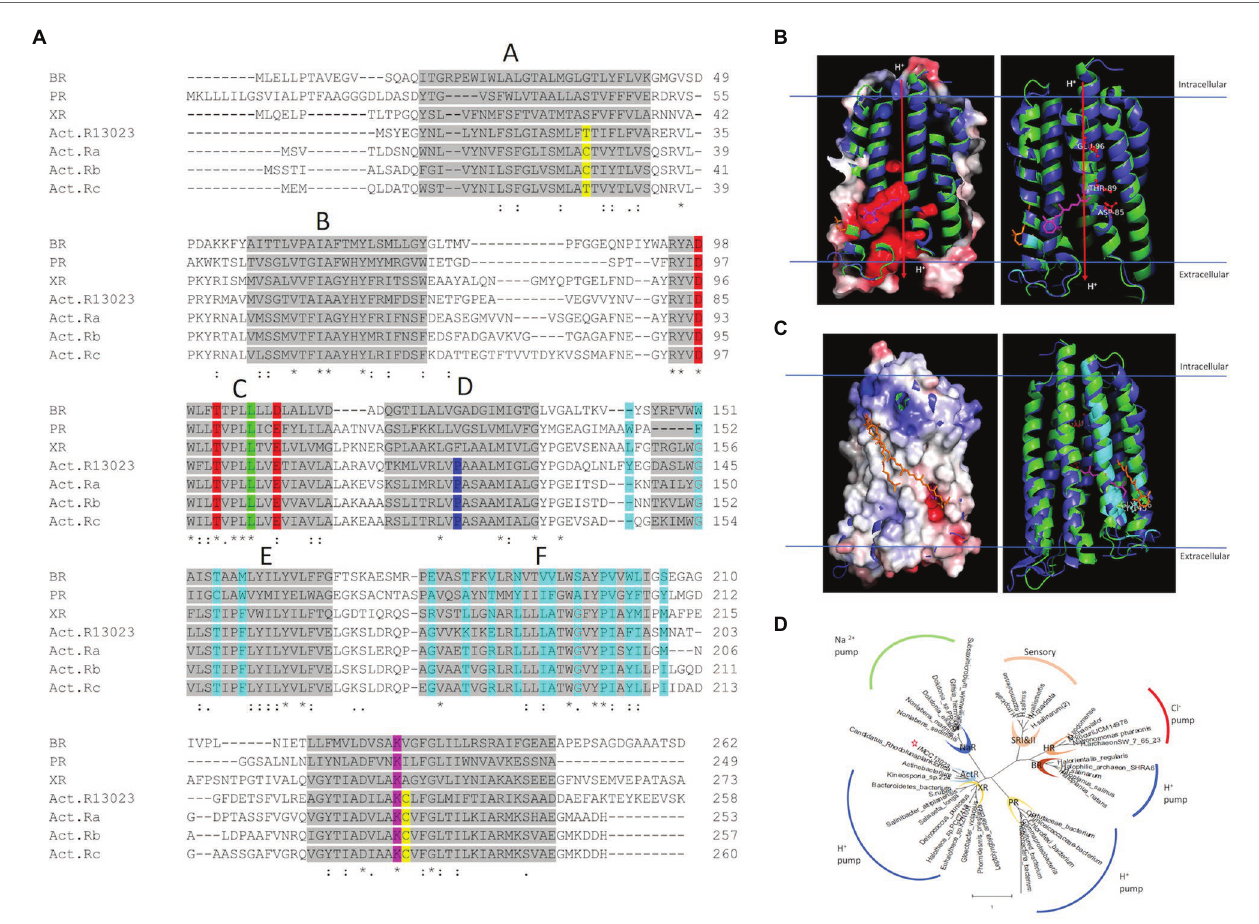
FIGURE 1 | Features of ActR-13023 vs. other microbial rhodopsins. (A) Multiple sequence alignment of ActR-13023 with bacteriorhodopsin (BR), proteorhodopsin (PR), xanthorhodopsin (XR), and actinorhodopsin from acI actinobacteria clades A, B, and C (ActR a–c). Gray highlights and the alphabet represent the helical segment. Cys/Thr on helix A and G (disulfide bond in ActR) is marked in yellow, DTE motifs in red, color tuning residue in green, phylogenetically differentiated ActR XR, Pro in blue, carotenoid interaction residues in cyan, and retinal-bound Lys in pink. (B) Functional visualization of ActR-13023 compared to light-driven outward proton pump. (C) Carotenoid interaction potential of ActR-13023. (D) Phylogenetic tree of ActR-13023 vs. other microbial rhodopsins (the tree was generated using MEGA X